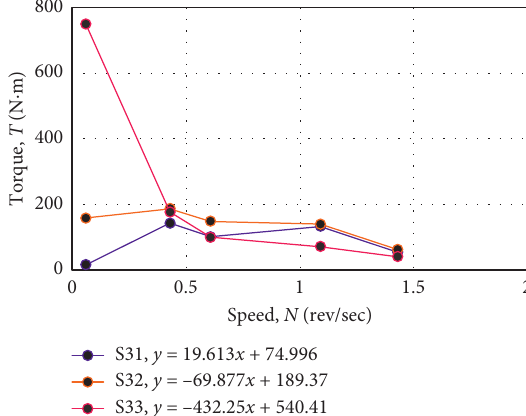
Figure 13: Torque for M40 grade concrete.